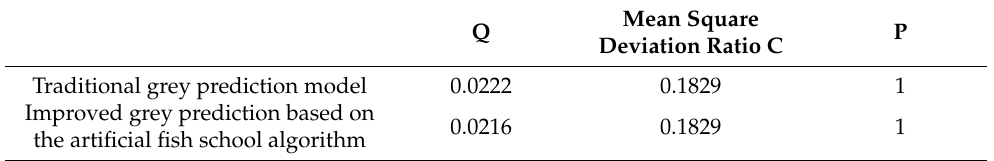
Table 8. Model inspection.